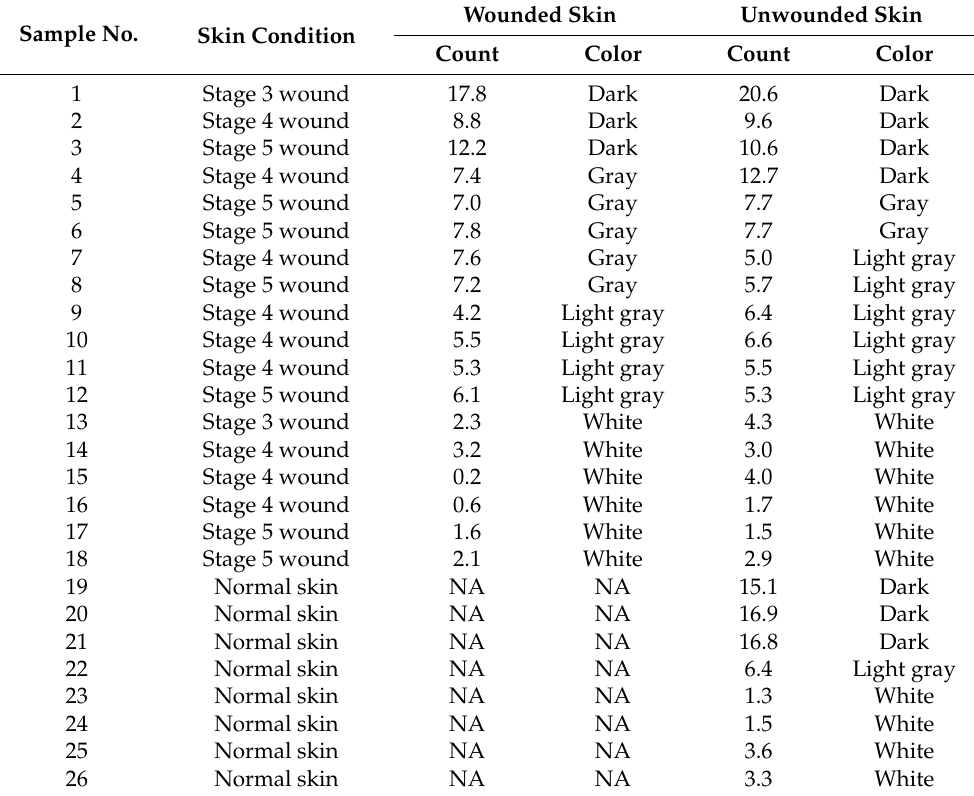
Table 2. Cell counting of melanocytes. Sample